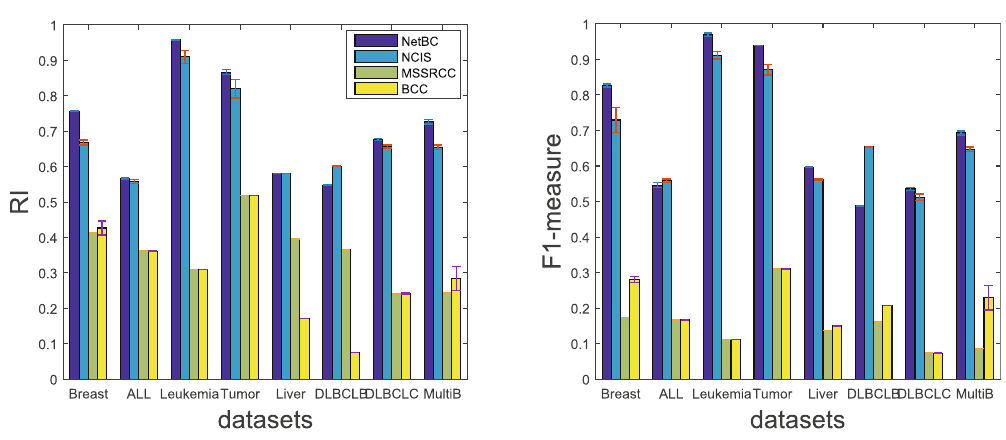
Figure 3. RI ( a ) and F1-measure ( b ) of different bi-clustering methods on eight